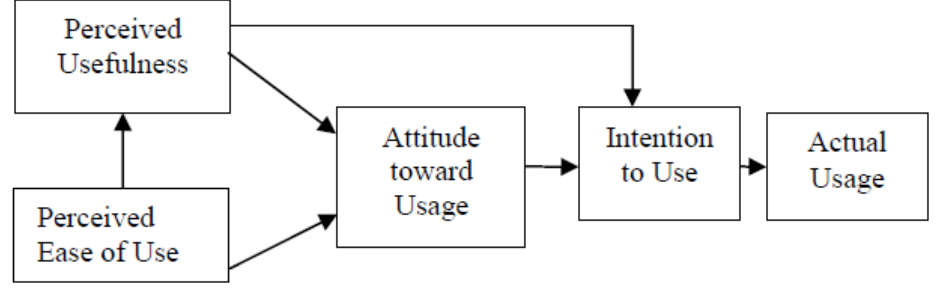
Figure 2 . The technology acceptance model (Davis,